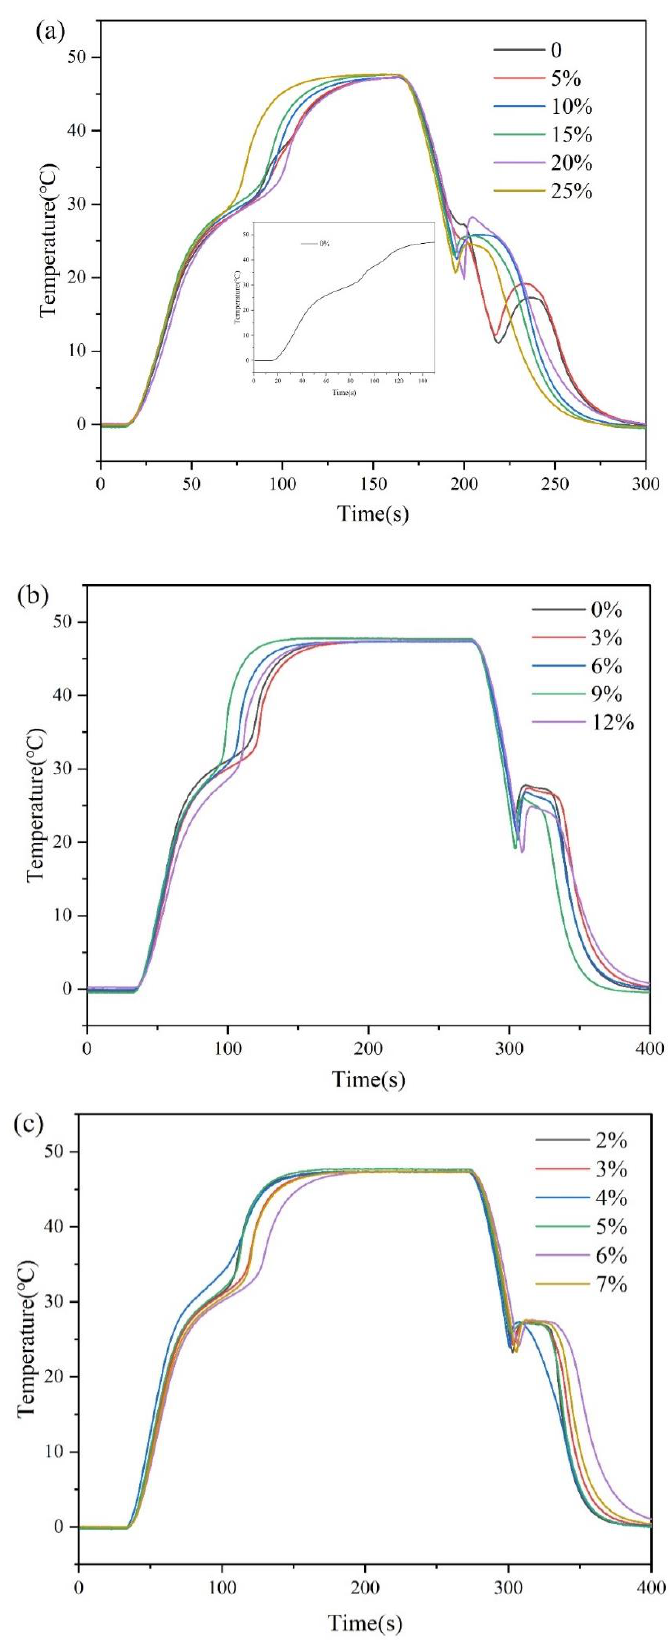
Figure 2. Cooling curves: ( a ) eutectic hydrated salts with different deionized water content; ( b ) COMPOSITE PCMs with different DHPT content; ( c ) composite PCMs with different Na 2 SiO 3 ·9H 2 O content. Table 1. The supercooling degree of different samples.